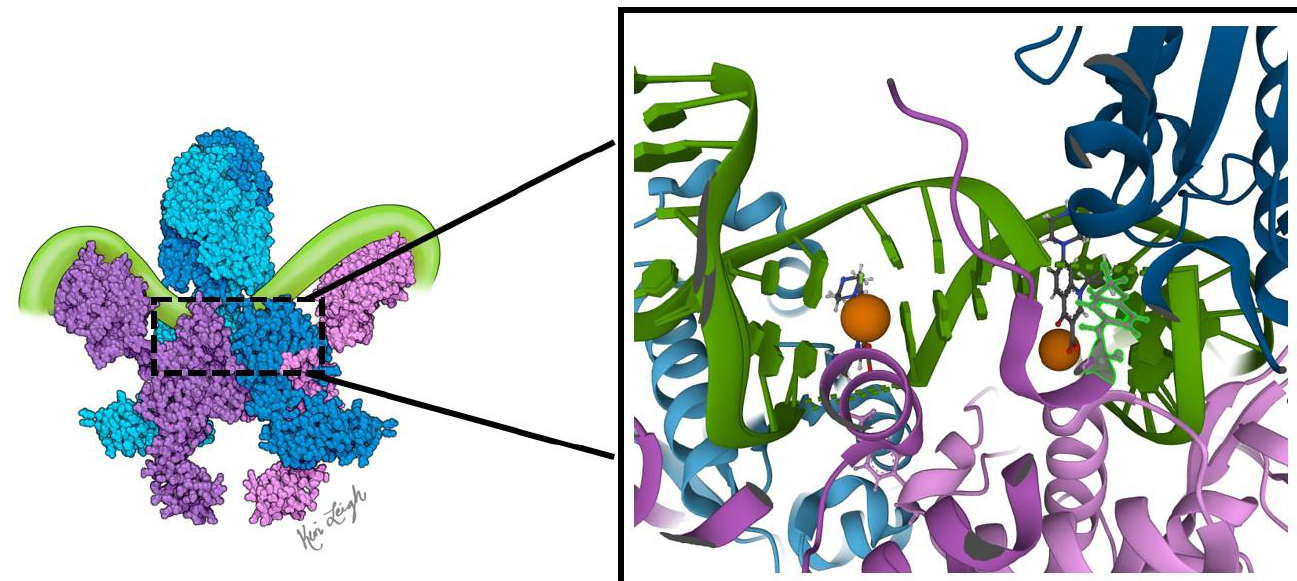
Figure 3. Binding of quinolones to DNA gyrase. The quinolone ciprofloxacin is shown bound to Mycobaterium tuberculosis DNA gyrase at the cleavage core in the dimer interface. Two quinolones (shown as ball and stick, color cpk) intercalate into the G-segment DNA (green) near the cleavage site. The noncatalytic Mg 2+ ion that is coordinated by the keto acid group is shown in orange. The key active site tyrosines in the A subunits are shown as ball and stick in pink and purple. The structure shown on the right is adapted from PDB ID 5BTC. The color scheme is the same as in Figure 1.